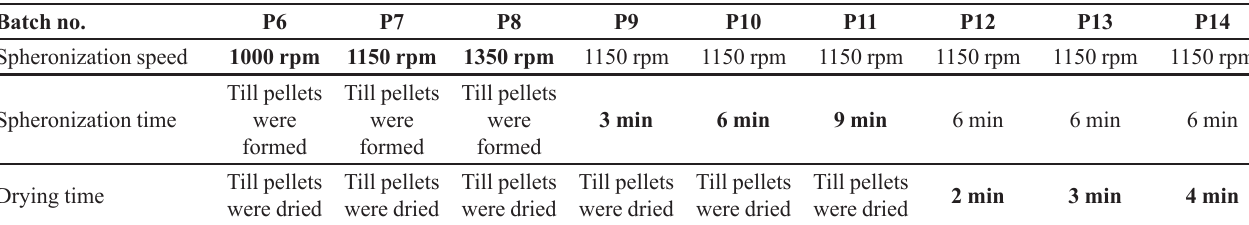
TABLE I - Optimization of various process variables for pellet formulation Batch